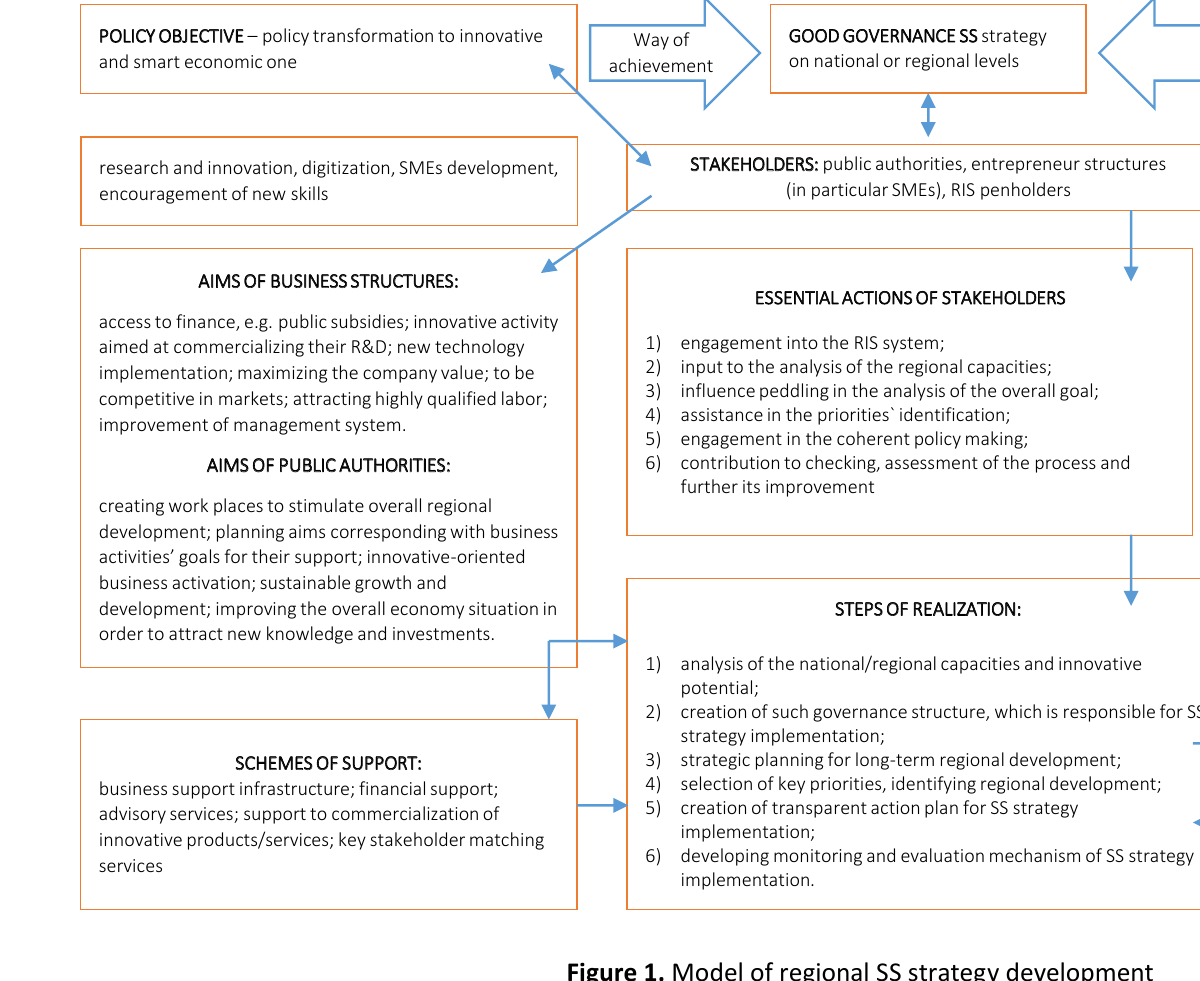
Figure 1. Model of regional SS strategy